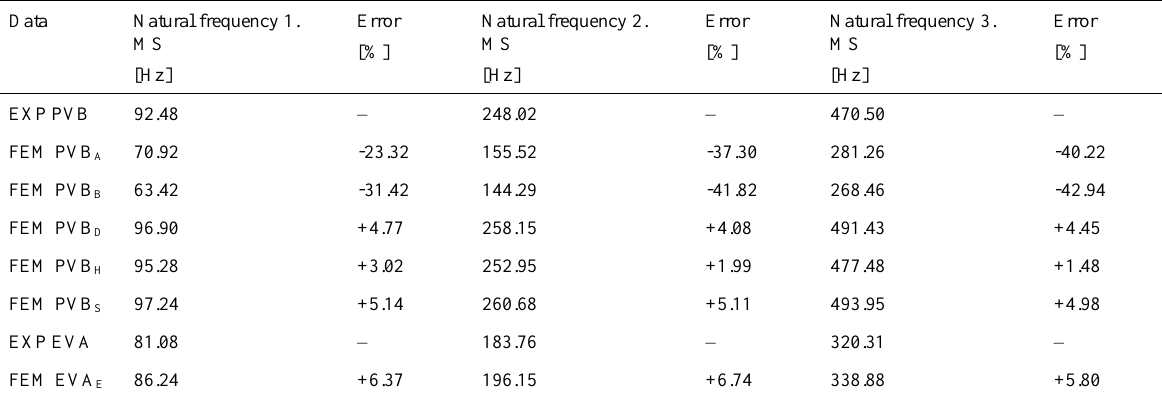
Table 3: Modal analysis: Comparison of experimental data and numerical predictions of natural frequencies for the first three mode shapes (MS).